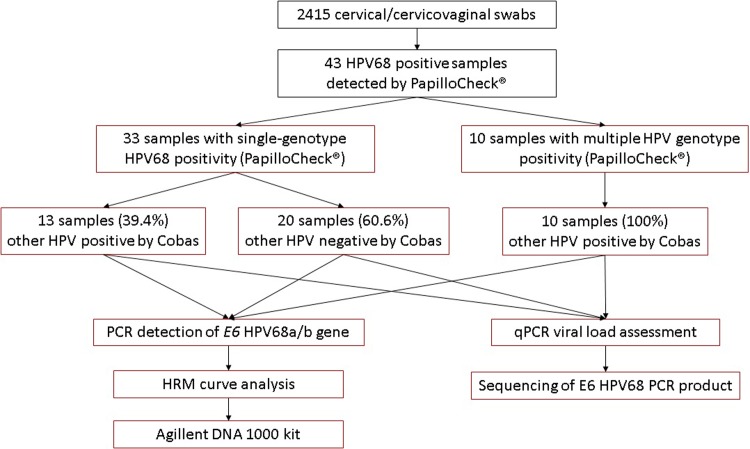
Study flowchart.